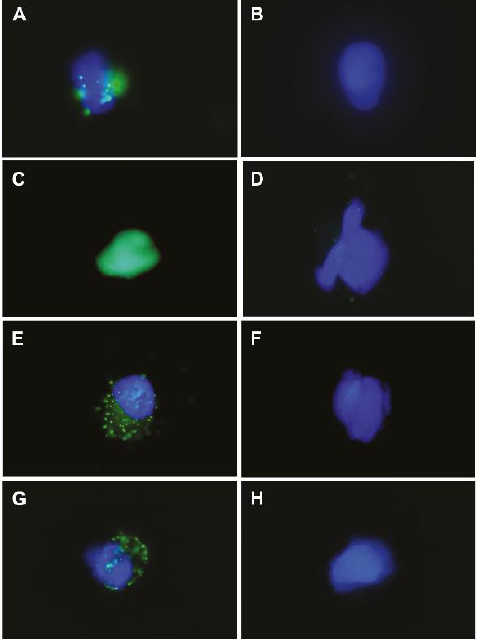
Figure 6. Fluorescence photomicrograph showing binding of the anti-GPR64 antibody to human sarcoma cell lines in vitro. ( A ) HTB166+sheep anti-GPR64 IgG antibody+AF488-labeled anti-sheep antibody. ( B ) HTB166+AF488-labeled anti-sheep antibody. ( C ) HT1080+sheep anti-GPR64 IgG antibody+AF488-labeled anti-sheep antibody. ( D ) HT1080+AF488-labeled anti-sheep antibody. ( E ) 143B+sheep anti-GPR64 IgG antibody+AF488-labeled anti-sheep antibody. ( F ) 143B+AF488-labeled anti-sheep antibody. ( G ) A673+sheep anti-GPR64 IgG antibody+AF488-labeled anti-sheep antibody. ( H ) A673+AF488-labeled anti-sheep antibody.